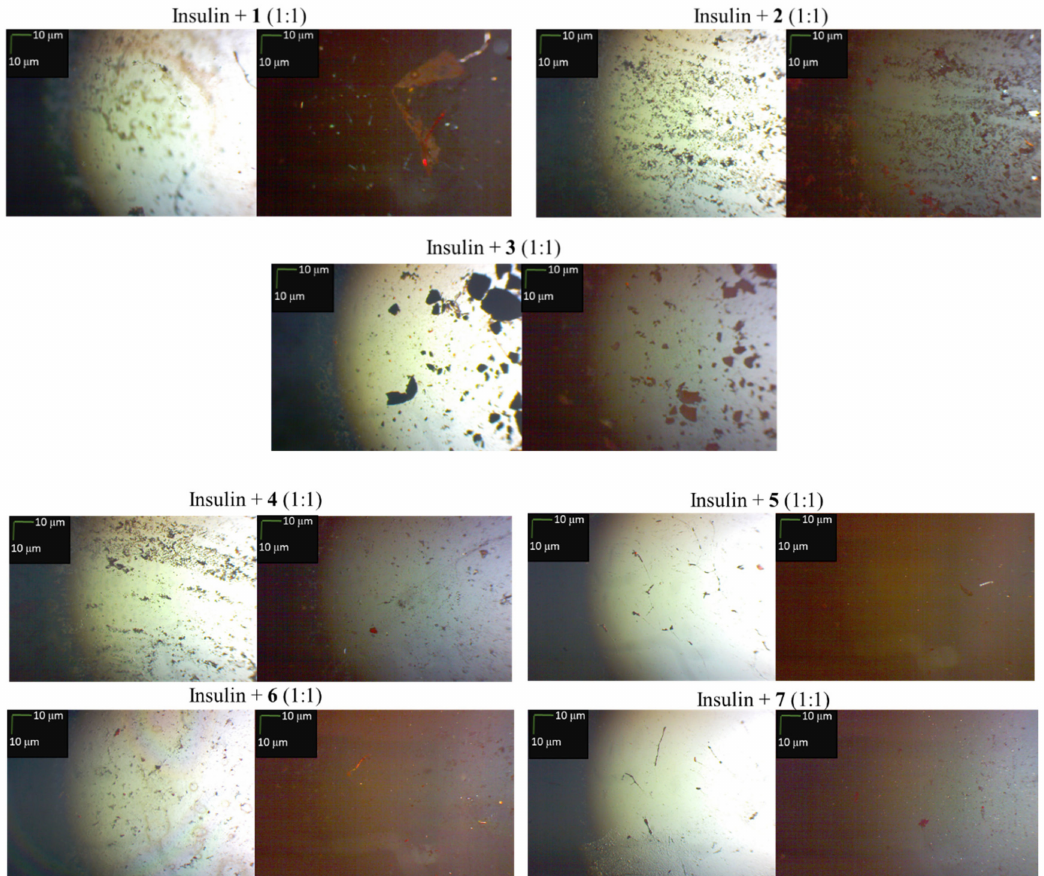
Figure 5. ( a ) UV spectra of mixtures (1:1) of insulin with one of the peptides 1 – 7 in the presence of Congo Red (CR). Results derived on the fourth day of incubation; ( b ) fluorescence intensity spectra of mixtures (1:1) of insulin with one of the peptides 1 – 7 in the presence of Thioflavin T (ThT), wavelength = 485 nm, after fourth day of incubation; ( c ) pictures of mixtures (1:1) of insulin with one of the peptides 1 – 7 , without a polarized filter (left side), with a polarized filter (right side). Scale bars, 10 µ m. Microscopic measurements have been performed on the fourth day of